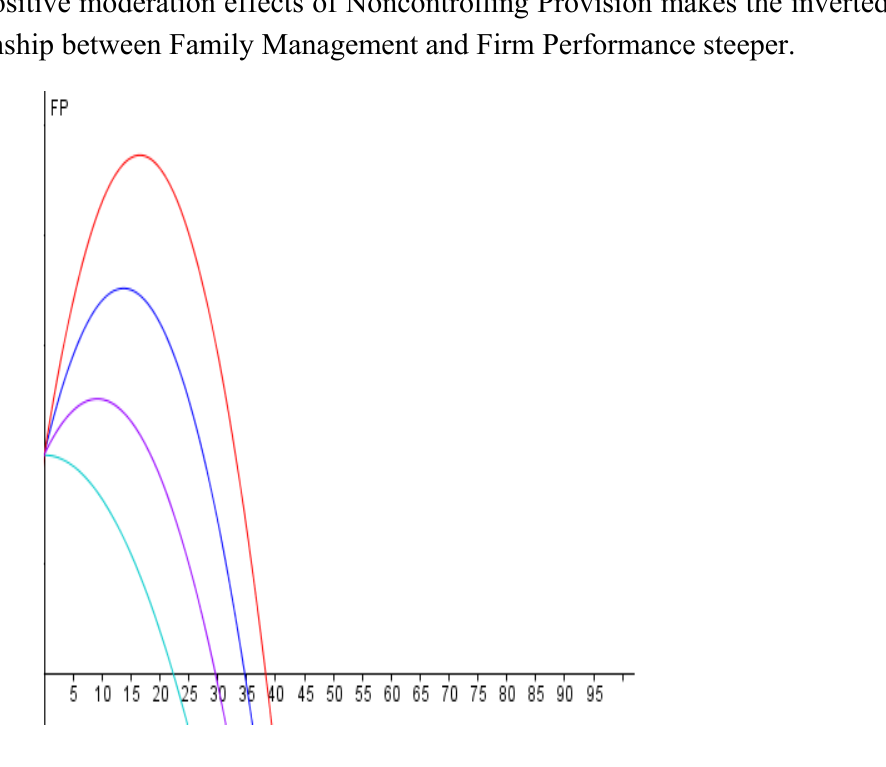
Figure 4. Significant Interactions between Family Ownership and Monetary Provision. Contrary to our hypothesis, the positive moderation effects of Monetary Provision make the inverted U-shaped relationship between Family Ownership and Firm Performance